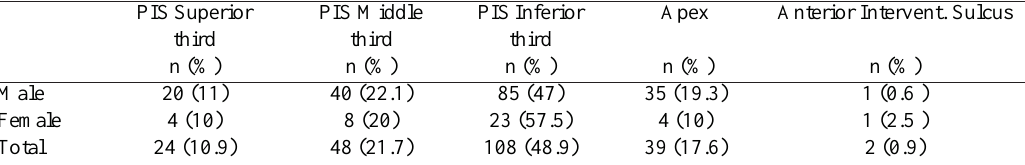
Table 2. Posterior interventricular artery´s site finalization by gender. PIS: Posterior interventricular